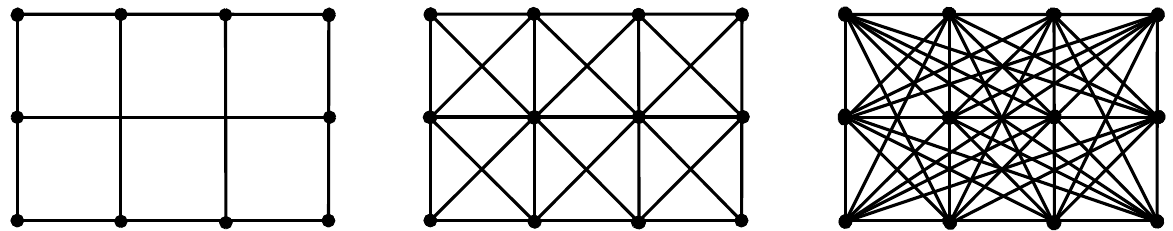
Figure 3. Fully connected CRF establishes pairwise potentials on all pairs of pixels in the image and has the ability to model long-range connections. From left to right: four-connected CRF, eight-connected CRF and fully-connected CRF.